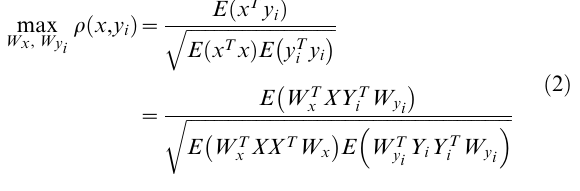
SSMVEPs ( f 1 – f 4 ) in frequency range of 3–15 Hz, which were calculated by Fast Fourier Transform (FFT) of consecutive non- overlapped trials from Oz site. FFTs revealed that responses